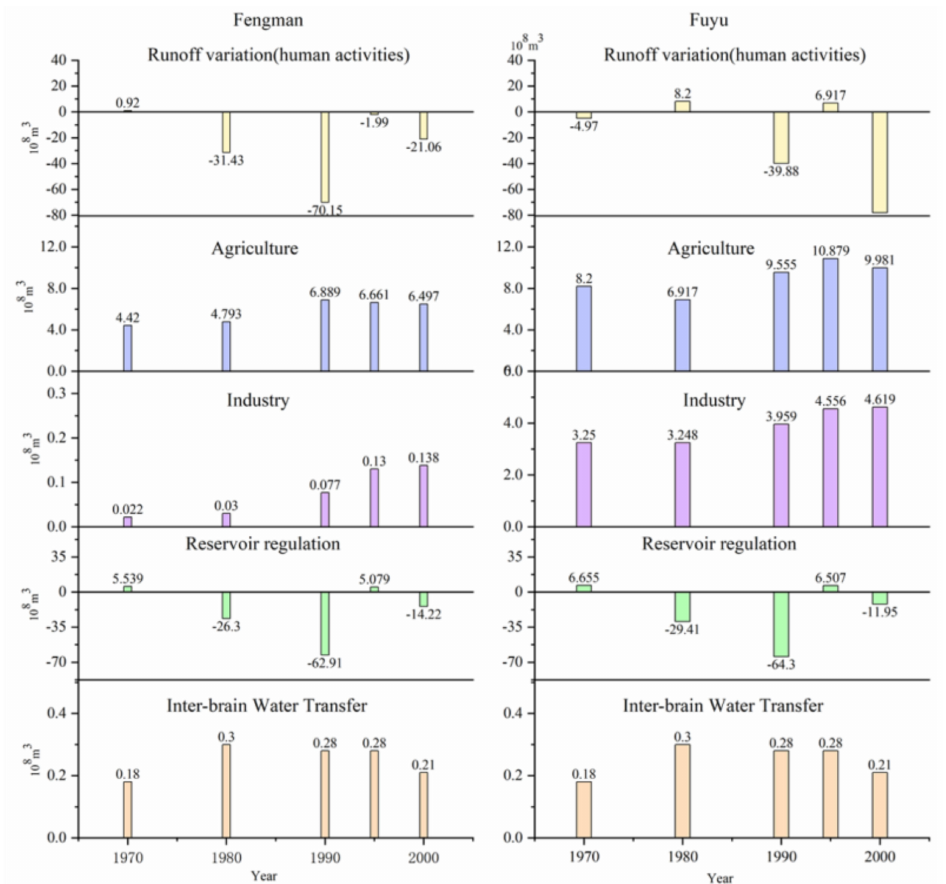
Figure 2. Comparison the impact of water intake on the measured runo ff change in Fengman and Fuyu